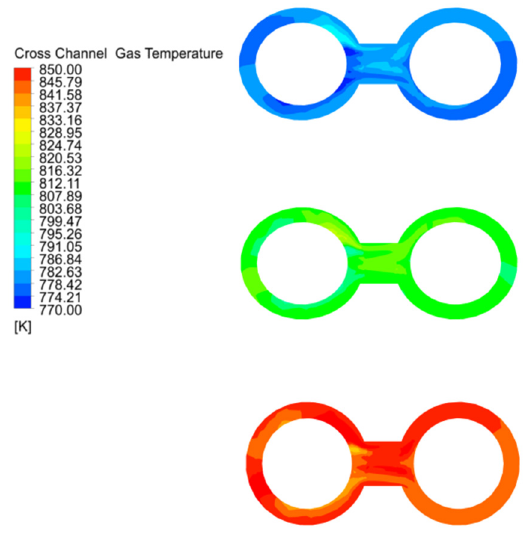
Figure 9. Gas temperature distribution and variation in the cross channel at 40 mm, 80 mm and 120 mm particle sizes.